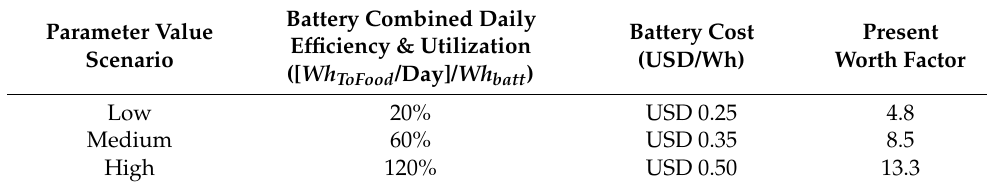
Table 6. MLCOE input parameter ranges for estimating LTO-regulated electricity costs in a DDS SEC.